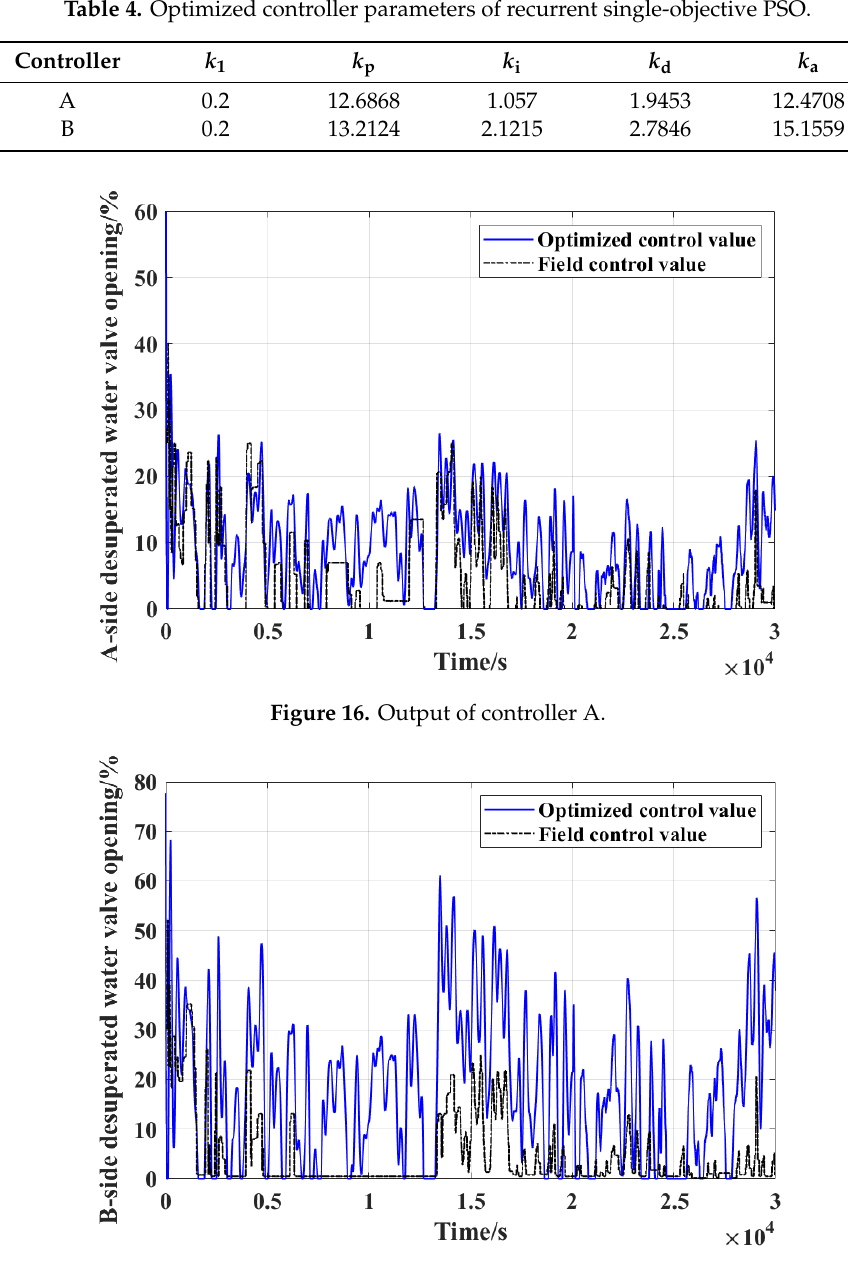
Figure 17. Output of controller B .